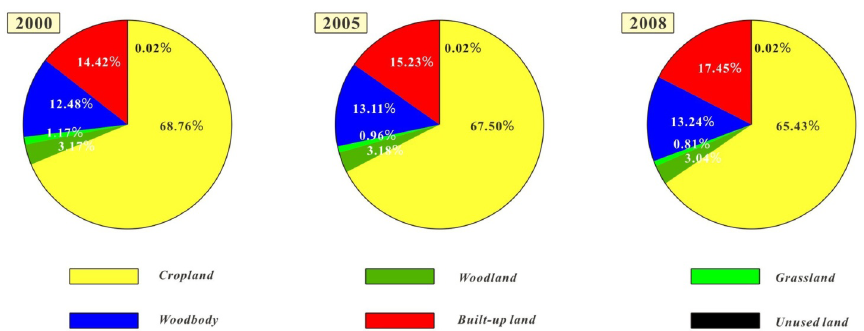
Figure 3. Land use change in Jiangsu during 2000–2008.